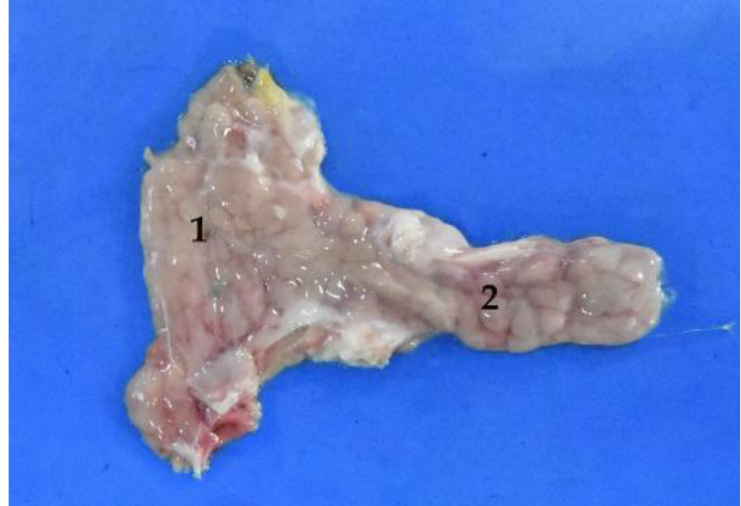
Figure 14. Isolated pancreas. ( 1 ) Right lobe; ( 2 ) left lobe.